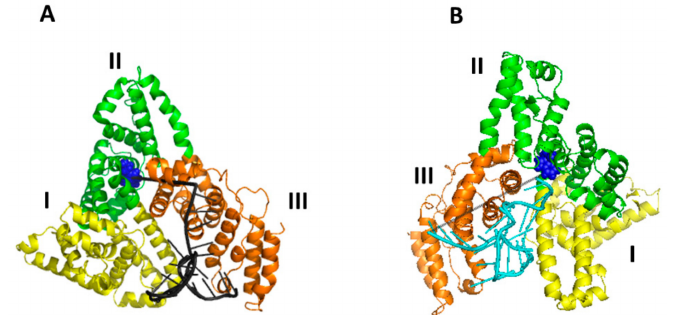
Figure 8. Graphical representation of the two proposed best models for the complex between HSA and miR-155: ( A ) Model 5 with miR-155 represented in grey; and ( B ) Model 6, with miR-155 represented in cyan. In HSA, domain I is colored in yellow, domain II in green and domain III in orange; Trp214 is shown as blue spheres. The distance D DA between Trp146 and the 5 (cid:48) end of miR-155 and the center of the aromatic rings of the lateral chain of Trp214 of HSA is marked by gray dashed